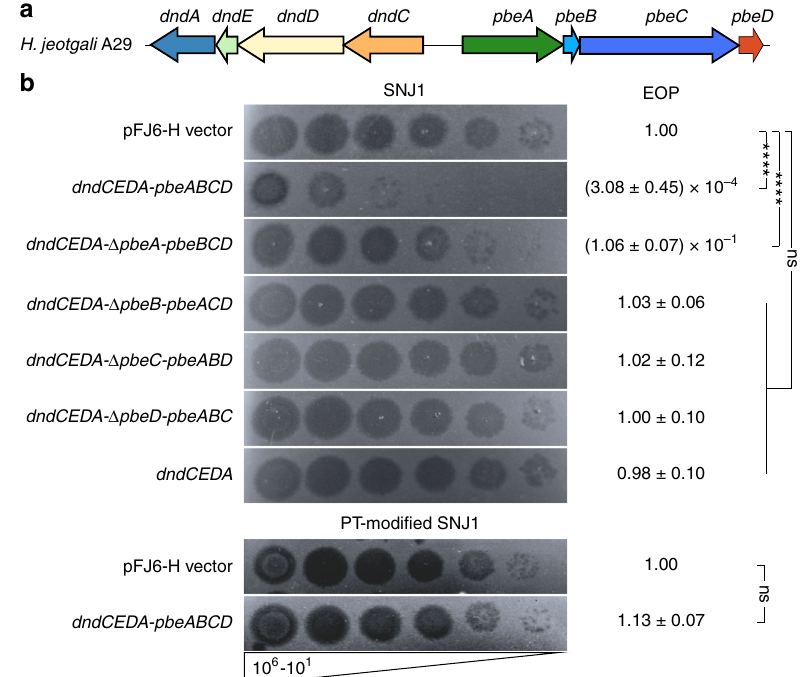
Fig. 4 DndCDEA-PbeABCD confers protection against the haloarchaeal virus SNJ1. a The dndCDEA-pbeABCD locus of H. jeotgali A29 is displayed. b Five microlitres each of a tenfold serial dilution (10 6 – 10 1 ) of SNJ1 virus was spotted onto CJ7-F cells carrying pWHU3808-derived plasmids and expressing the genes indicated on the left. The EOPs are listed on the right. The EOPs were determined by dividing the SNJ1 titre obtained by plating on CJ7-F expressing dndCDEA-pbeABCD and derivatives by the titre of SNJ1 plated on CJ7-F(pFJ6-H). The values represent the mean ± SD for three independent experiments. **** p -value < 0.0001, using one-sample t -test (Hypothesis Testing). Ns, not signi fi cant. Compared to the strong protection against non-PT SNJ1, CJ7-F cells are susceptible to PT-modi fi ed SNJ1, even in the presence of DndCDEA-PbeABCD. Source data are provided as a Source Data fi